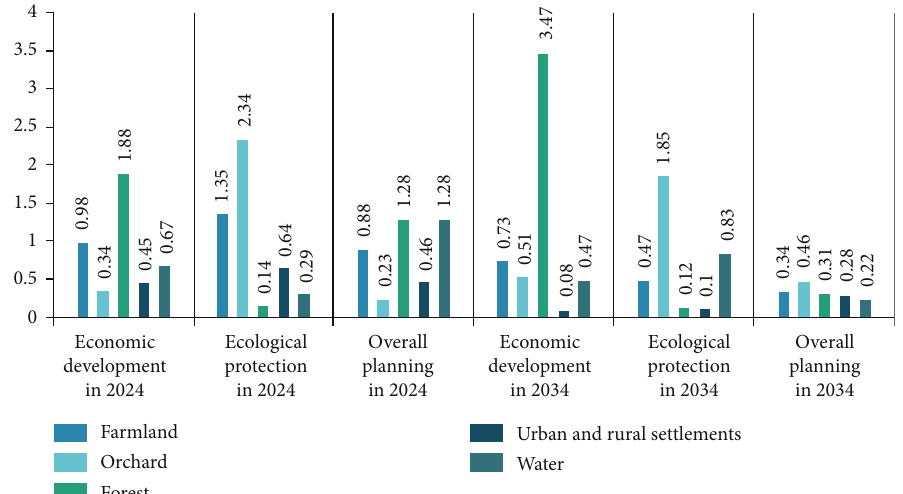
Figure 9: Relative errors of spatial optimization results and quantitative optimization results of PSO landscape pattern for 2024 and 2034 for each